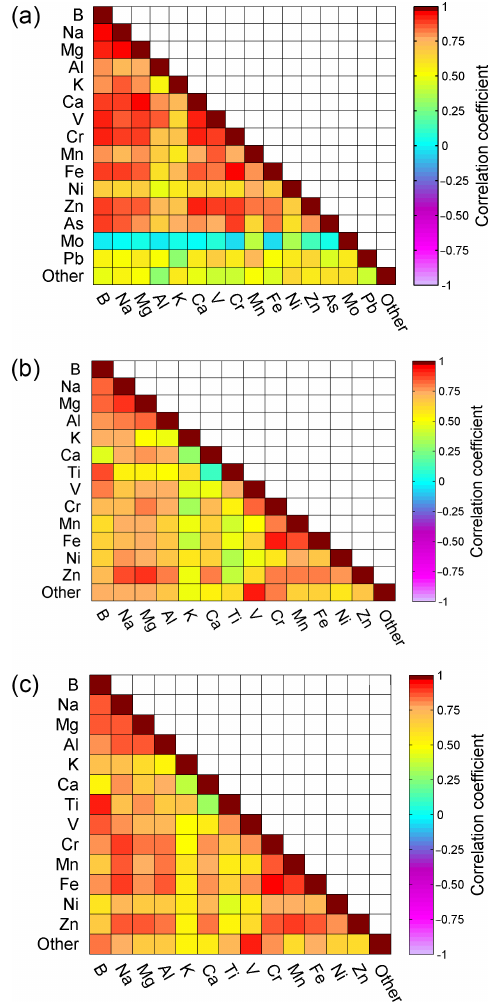
Figure 5. Spearman correlations of trace metal species in the PM 1 (a) , PM 1–2 . 5 (b) and PM 2 . 5–10 (c) size